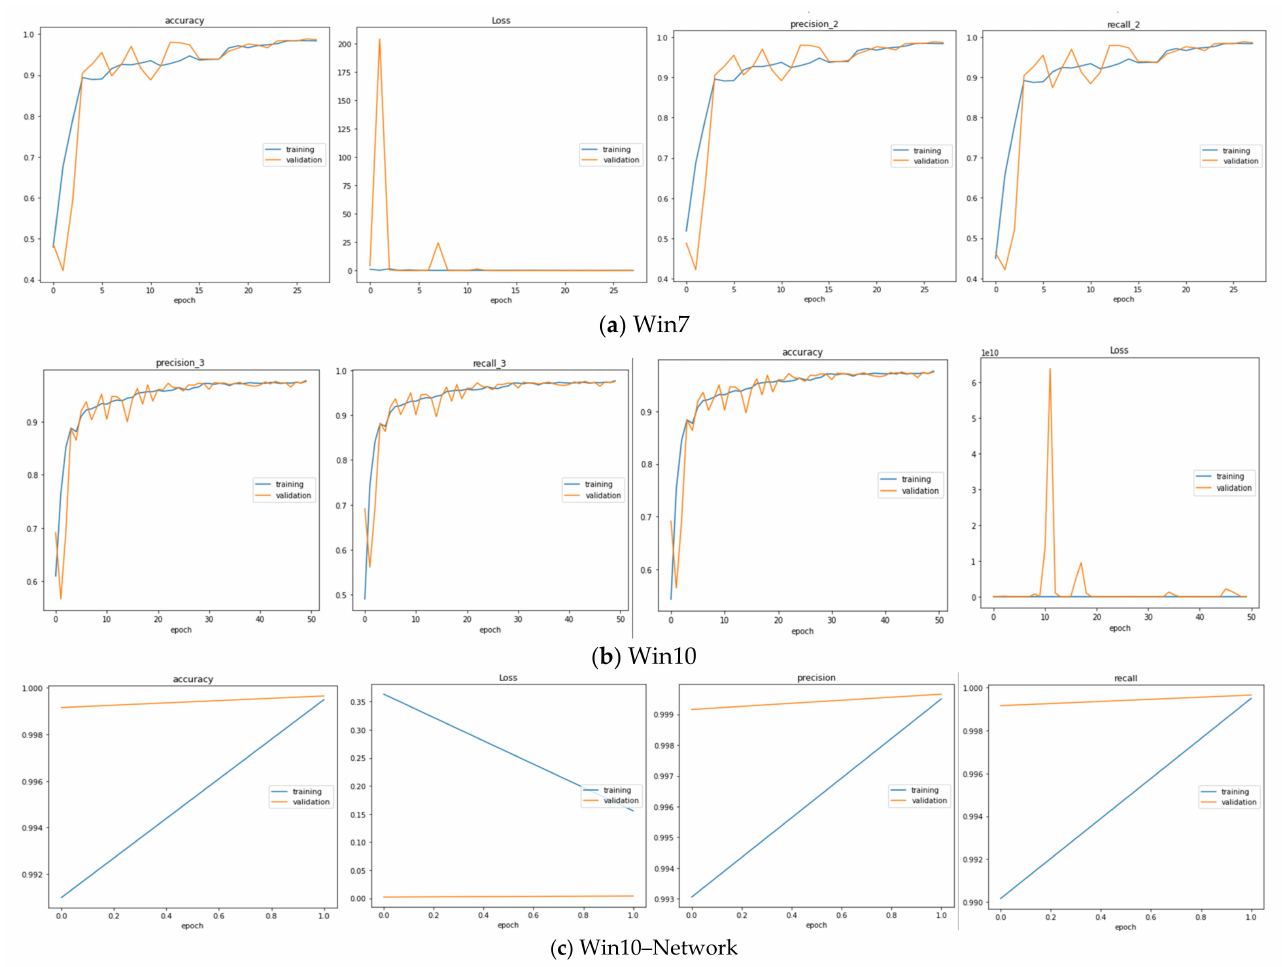
Figure 6. ( a – c ) The training and validation accuracy, F1-score, loss, recall, and precision after training the DenseNet model on the ToN-IoT